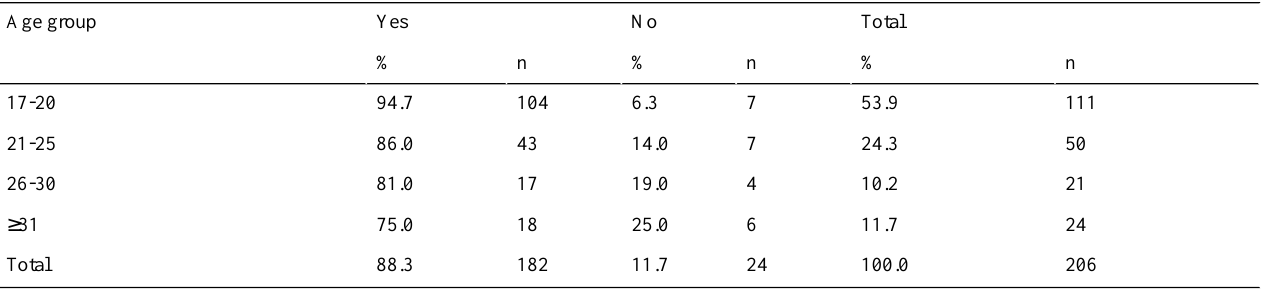
Table 4. Cross tabulation comparing number and percentage of students who access to social media by age group (Cross tabulation chi-square P =.035). TotalNoYesAge group